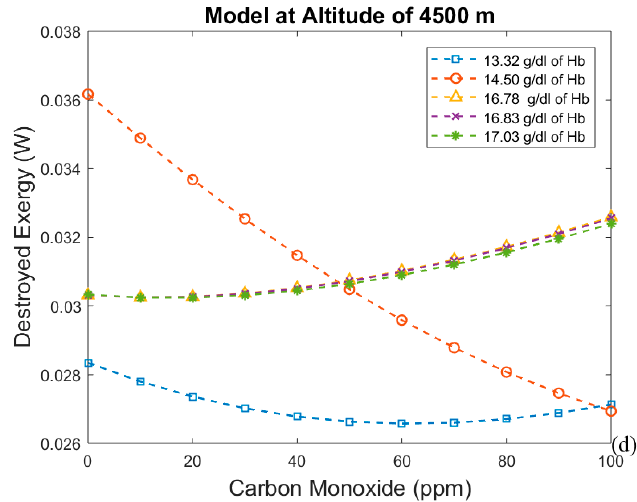
Figure 9. Destroyed exergy as function of carbon monoxide and hemoglobin concentration at ( a ) 0 m, ( b ) 1500 m, ( c ) 3000 m, and ( d ) 4500 m.